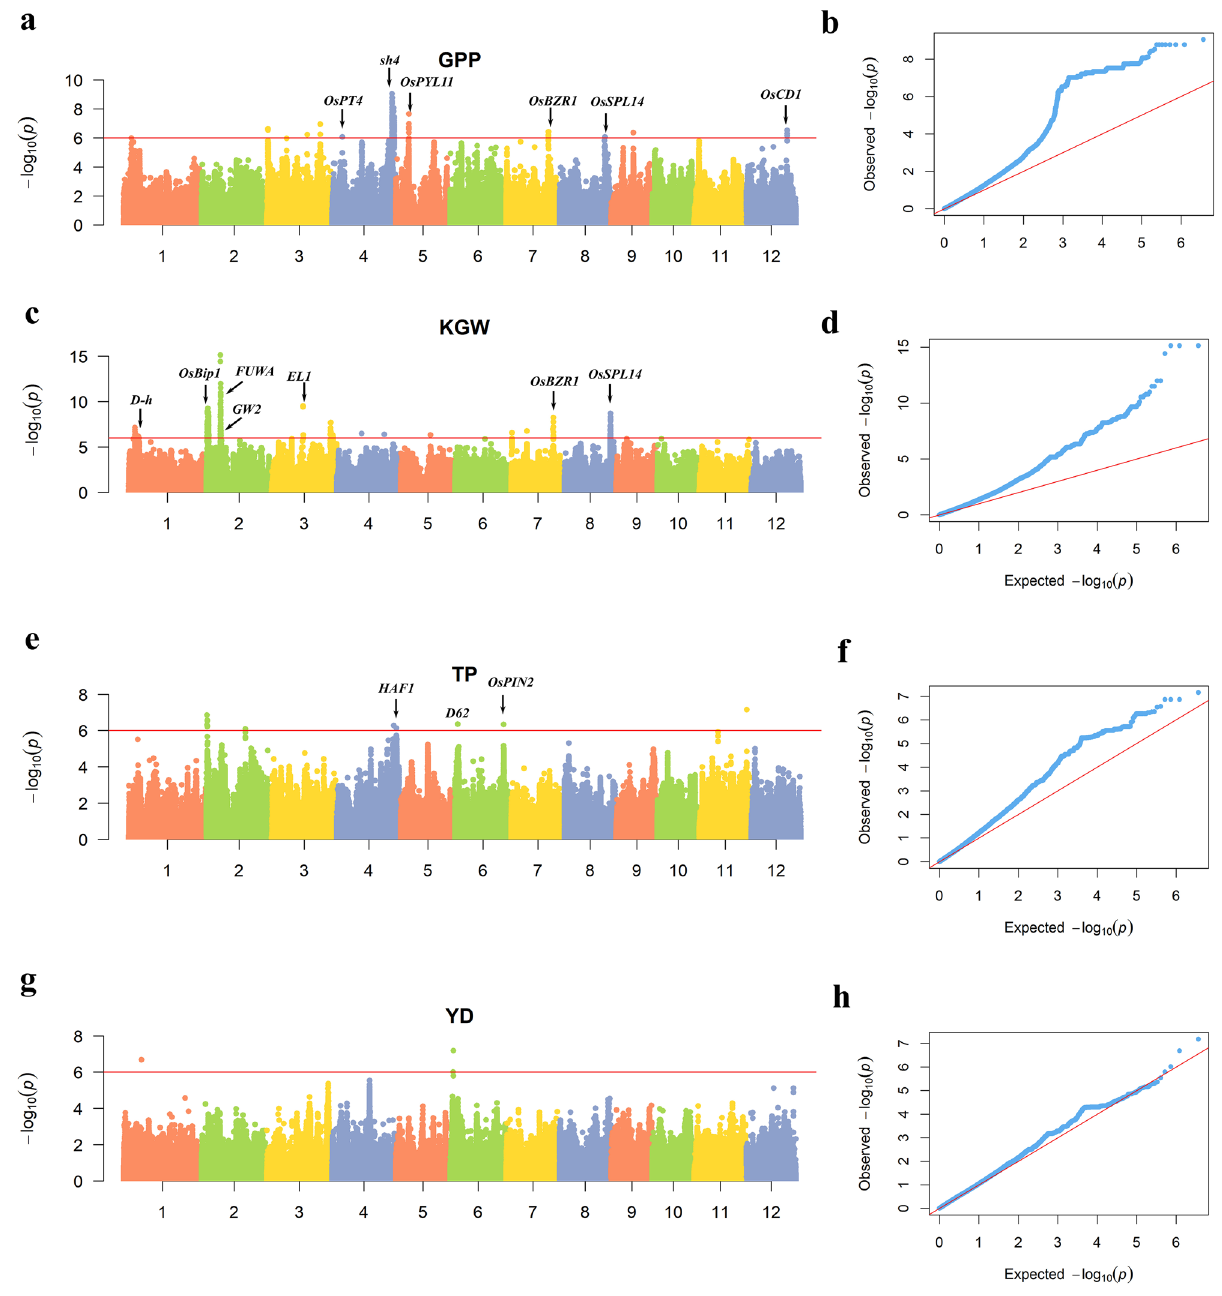
Figure 1. Meta-analyses result for GWAS. ( a , b ) Manhattan plots and quantile–quantile plots of GPP. ( c , d ) Manhattan plots and quantile–quantile plots of KGW. ( e , f ) Manhattan plots and quantile–quantile plots of TP. ( g , h ) Manhattan plots and quantile–quantile plots of YD. The genome-wide significant P- value threshold P < 10 –6 is indicated by a horizontal line. The loci with well-characterized genes are indicated near the association